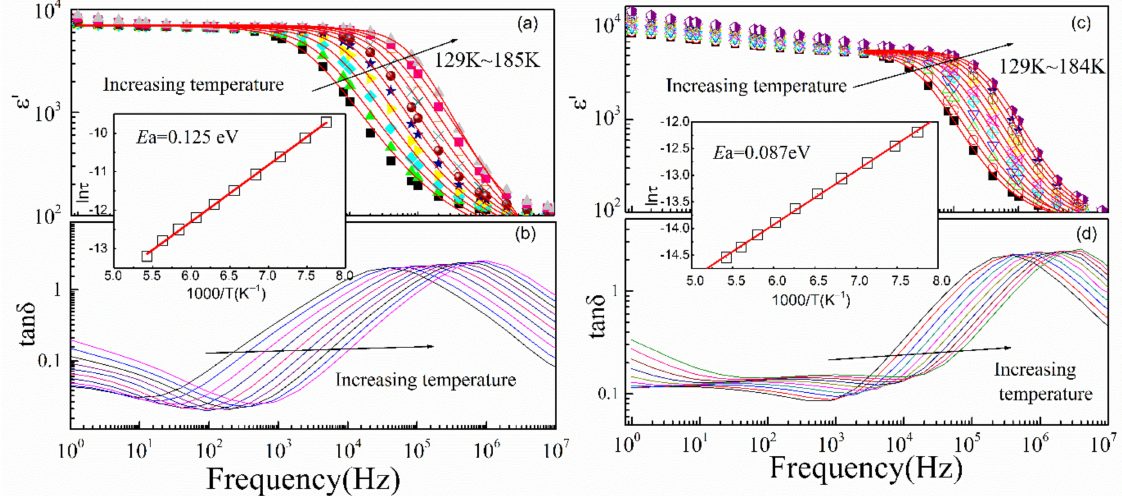
Figure 6. Frequency dependence of dielectric properties of CaCu 3 Ti 4 O 12 ( a , b ) and La 2/3 Cu 3 Ti 4 O 12 ( c , d ) ceramics, respectively, in a low-temperature range (129–184 K). In figures ( a , c ), the experimental data are represented by the solid symbols, and the fitting results by the modified Debye’s model are the lines. Insets show the temperature dependence of the relaxation time τ